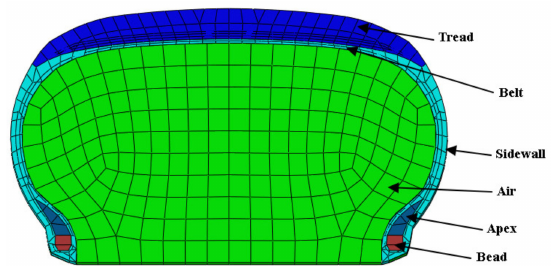
Figure 1. 2D FEM of tire.